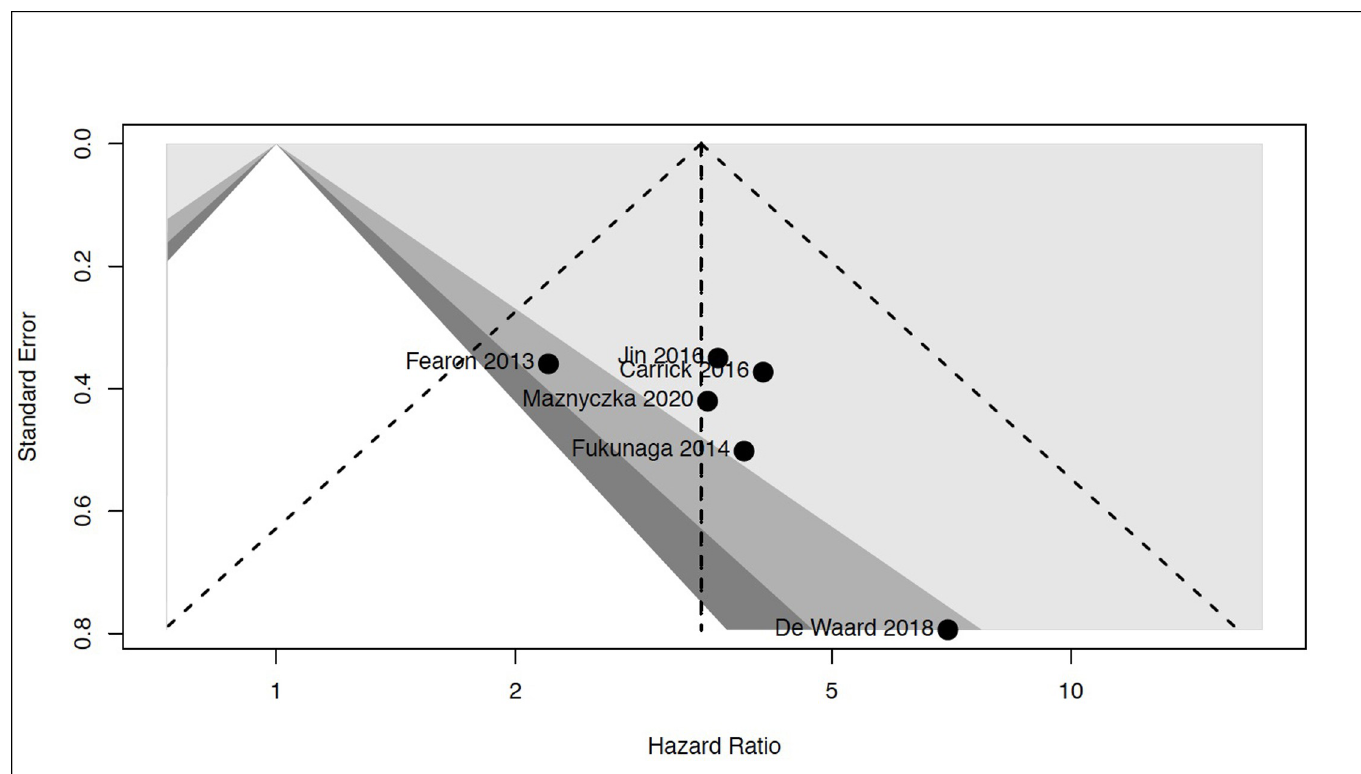
Fig 6. Funnel plot. The funnel plot showed no asymmetry, suggesting no publication